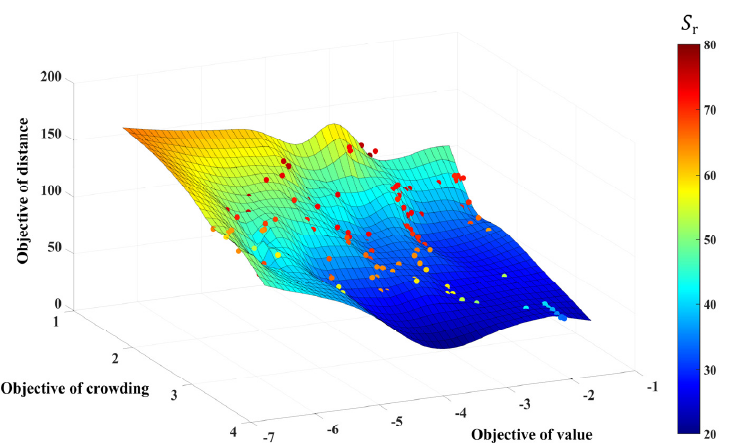
Figure 8. Non-dominated solutions of initial route solutions of one independent experiment. The three axes correspond to the three minimized objective function values. The satisfaction evaluation S r of each non-dominated solution (represented as a dot) can refer to the values on the color scale according to the dot’s